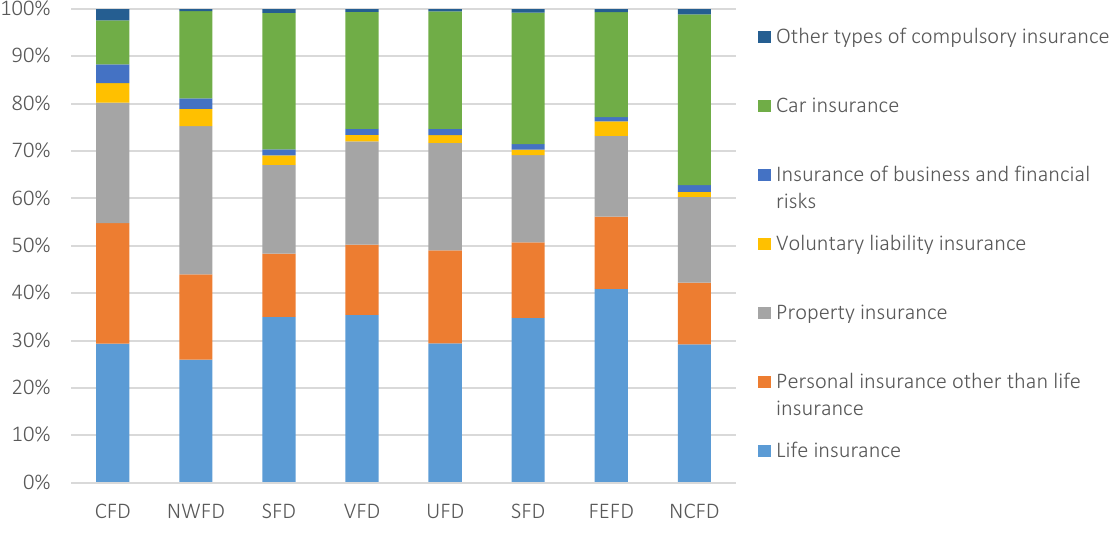
Figure 4. Structure of insurance premiums in the federal districts in